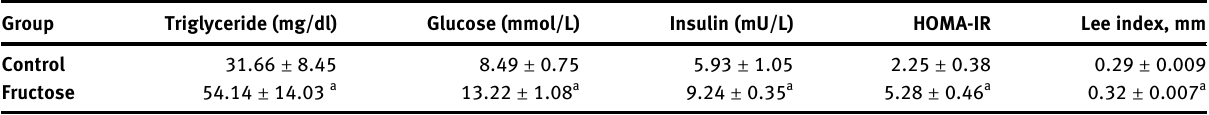
Table  : Biochemical parameters of groups.